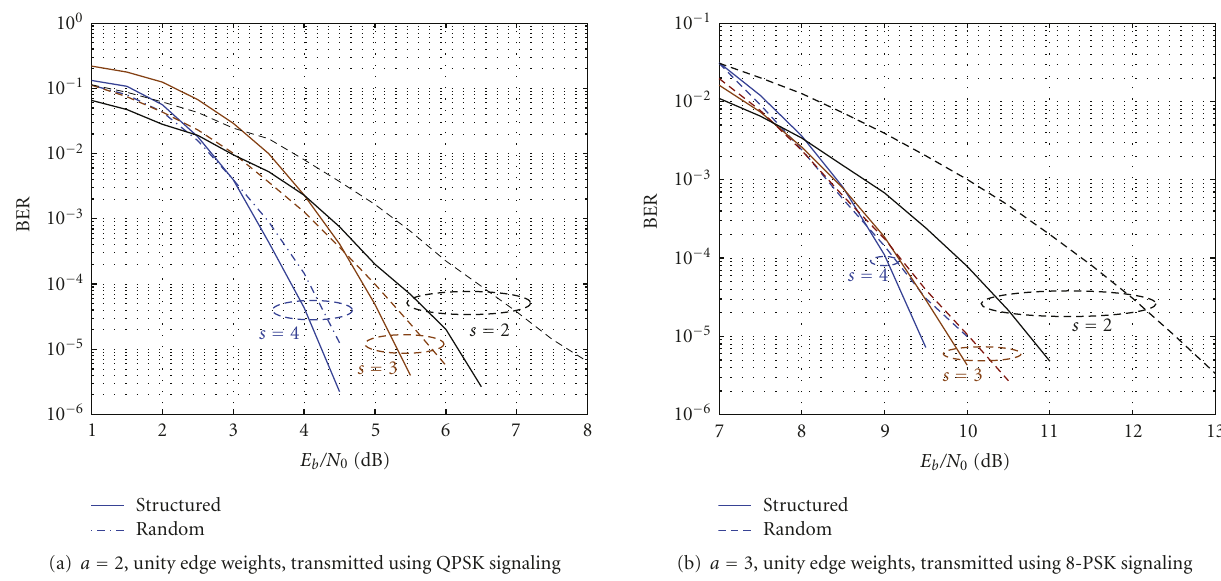
Figure 4: Performance of structured and random LDPC codes transmitted using matched signals over the AWGN